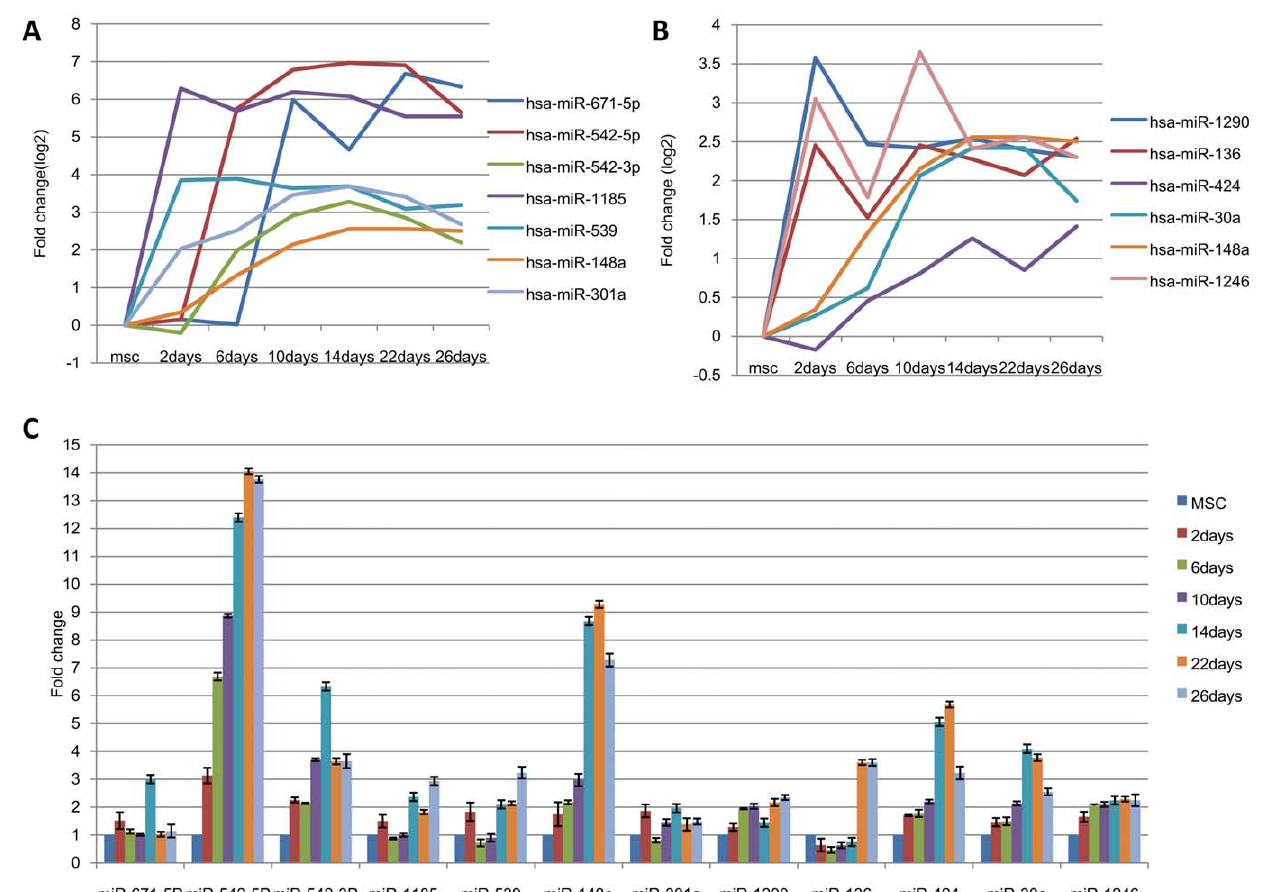
Figure 4. Over-expressed microRNA selection and analysis. A: The expression of seven microRNAs that changed $ 4-fold were analyzed by microRNA microarray. B: The expression of the top 6 highly expressed microRNAs (normalized data $ 6) was analyzed by microRNA microarray. C: The expression of the 12 screened over-expressed microRNAs was analyzed by qRT-PCR.